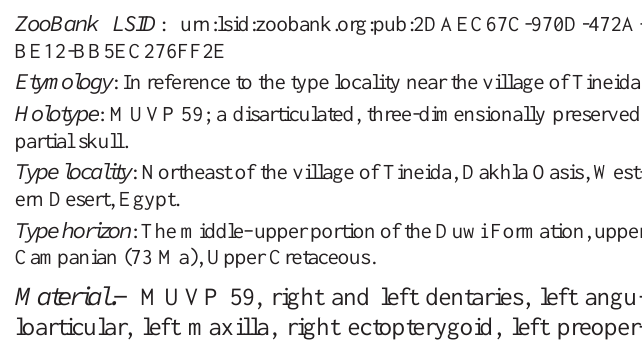
Fig. 1. Location and geological map of the Dakhla Oasis in the Western Desert, central Egypt, depicting outcrops of Upper Cretaceous rock units. MUVP 59 was recovered from the Duwi Formation exposed near the village of Tineida. Map of Egypt with dashed lines indicating the position of the field area ( A ), and map of studied area ( B ). Modified after El Khawaga et al.